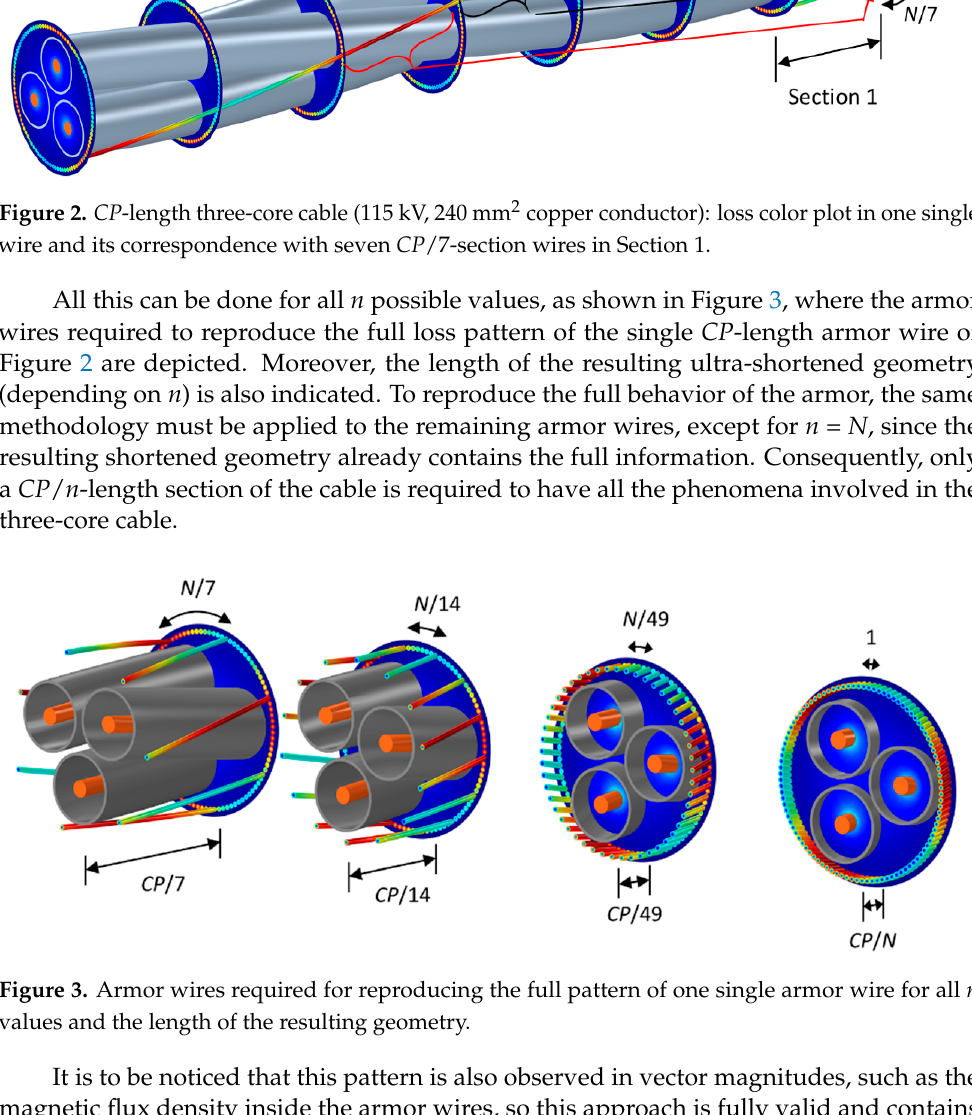
Figure 2. CP -length three-core cable (115 kV, 240 mm 2 copper conductor): loss color plot in one sin- gle wire and its correspondence with seven CP /7-section wires in Section 1.